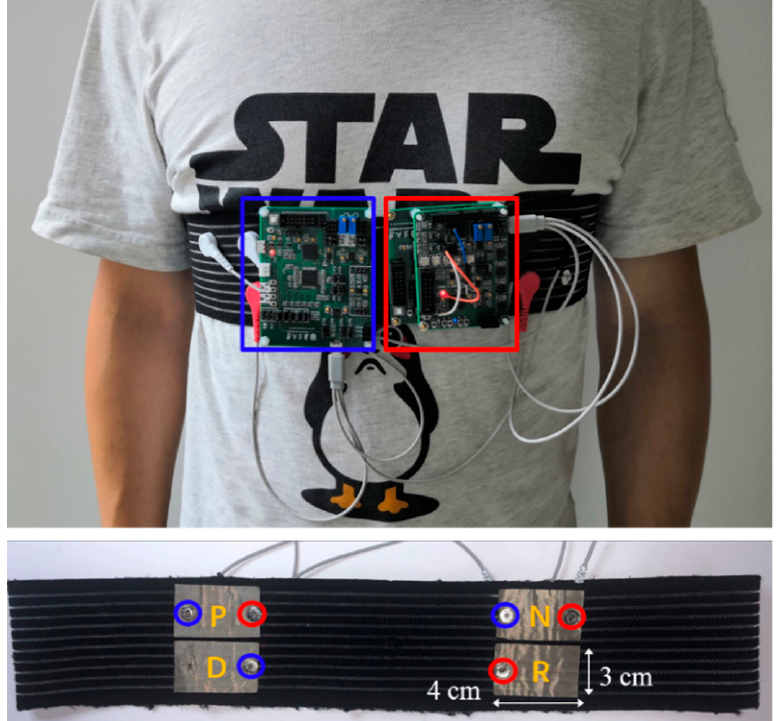
Figure 9. Devices and bandage electrodes for human body ECG acquisition using the C-DRL method and the proposed method.